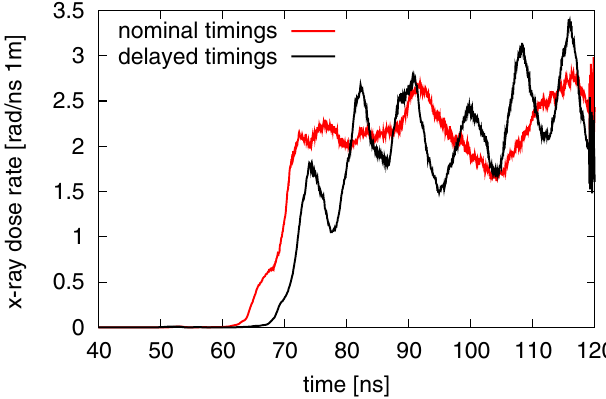
FIG. 12. Simulated x-ray dose rate for uniform cell firings spaced 3.3 ns apart (nominal timing) and cell firing times of 0, 0.3, 3.3, 11.0, 15.7, and 20.3 ns (delayed timings).